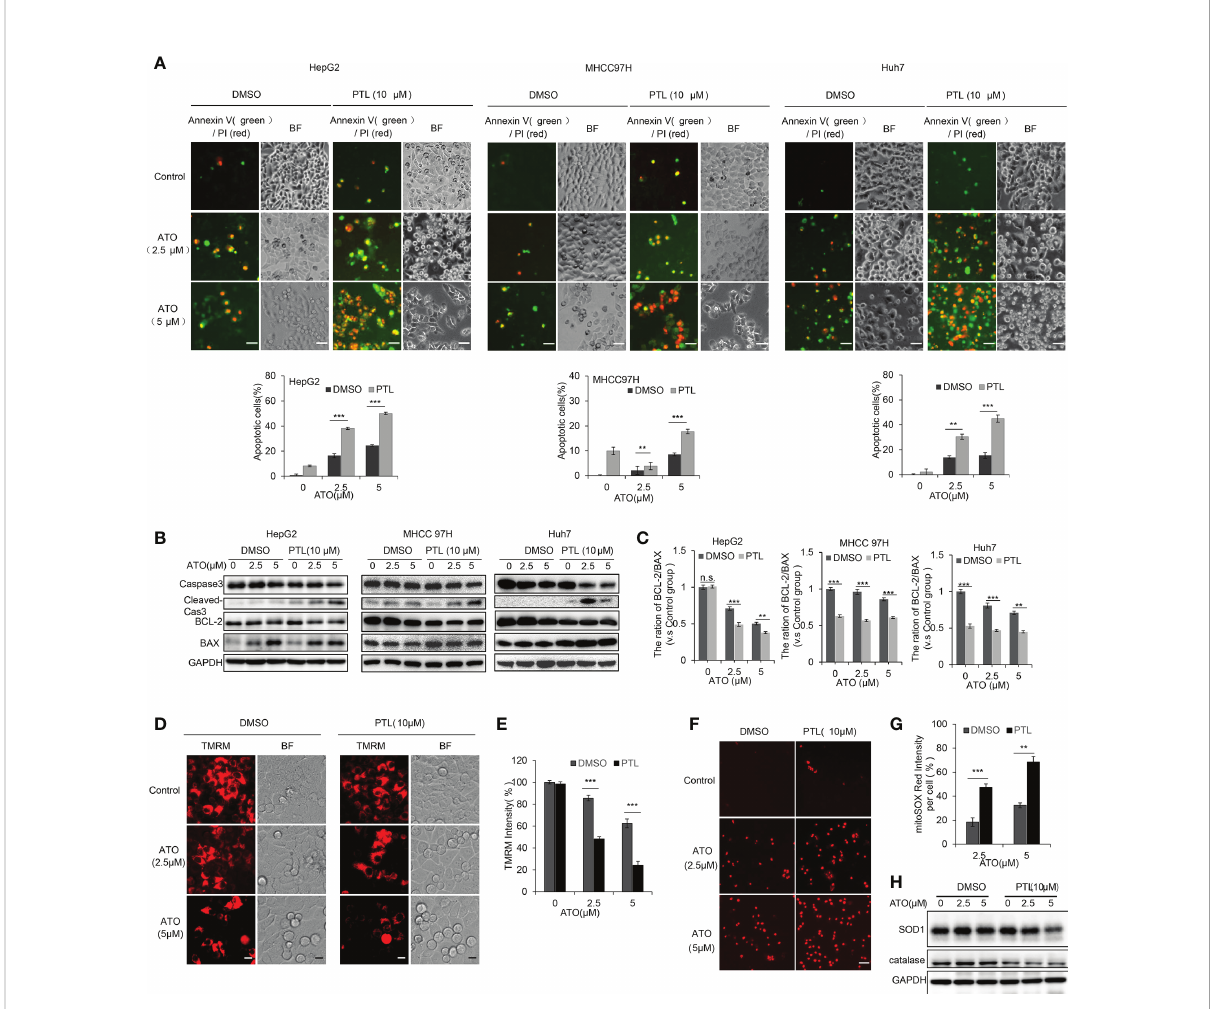
FIGURE 2 PTL promotes the cell apoptosis of HCC cell lines mediated by ATO via weakening the mitochondrial membrane potential and elevating ROS. Exposure to indicated concentrations of ATO, PTL and ATO plus PTL for 12 h or 24 h. (A) Apoptotic cells were analyzed by fl uorescence microscope and Flow cytometry (** P < 0.01; *** P < 0.001). (B) The cells were harvested and the indicated proteins were analyzed using western blotting, the expression of proteins were quanti fi ed as in (C) ; Columns, mean; bars, ± S.D. of 3 independent experiments (** P < 0.01; *** P < 0.001; n.s, no signi fi cance). (D) HepG2 cells were stained with TMRM and the images were captured using fl uorescence microscope. Scale bar: 10 m m. (E) The relative intensity of TMRM in the samples was quanti fi ed (n = 200). Columns, mean; bars, ± S.D. of 3 independent